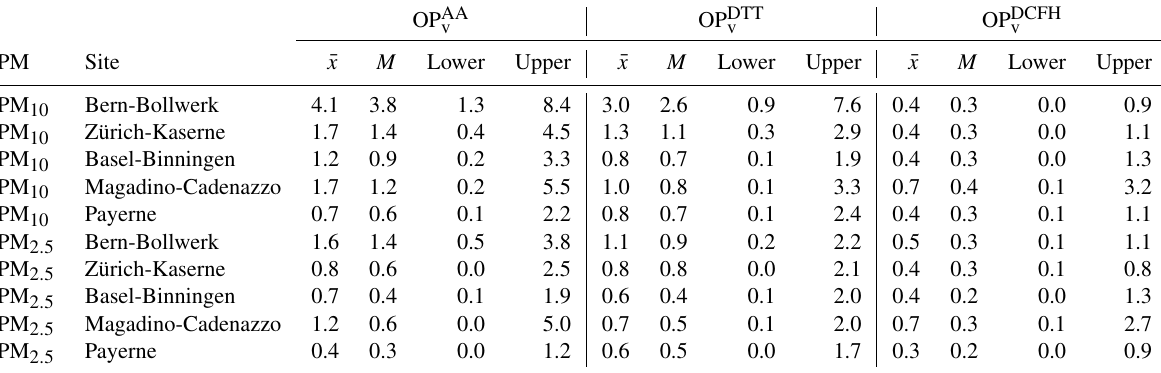
Table 2. Simple summary statistics for three OP v assays, two PM size fractions, and five sampling sites in Switzerland between June 2018 and May 2019. ¯ x and M represent the mean and median, respectively, while “lower” and “upper” refer to the 2.5% and 97.5% quantiles (which contain 95% of the observations). The summaries have been rounded to one decimal place and the units are nmolmin − 1 m − 3 for OP AA v and OP DTT v and nmolH 2 O 2 m − 3 for OP DCFH